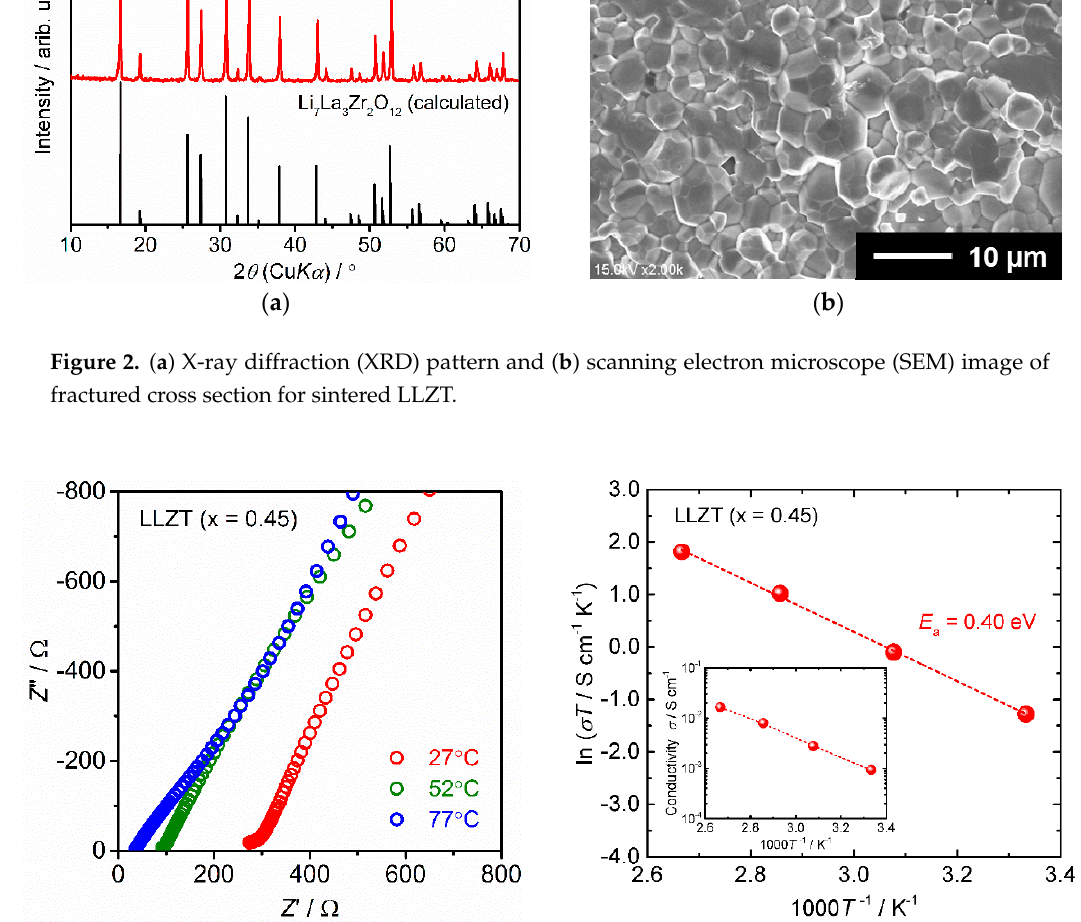
Figure 3. ( a ) Nyquist plot of alternating current (A/C) impedance of LLZT at 27 °C. ( b ) Arrhenius plot of the conductivity σ for LLZT plotted against the inverse of measurement temperature.